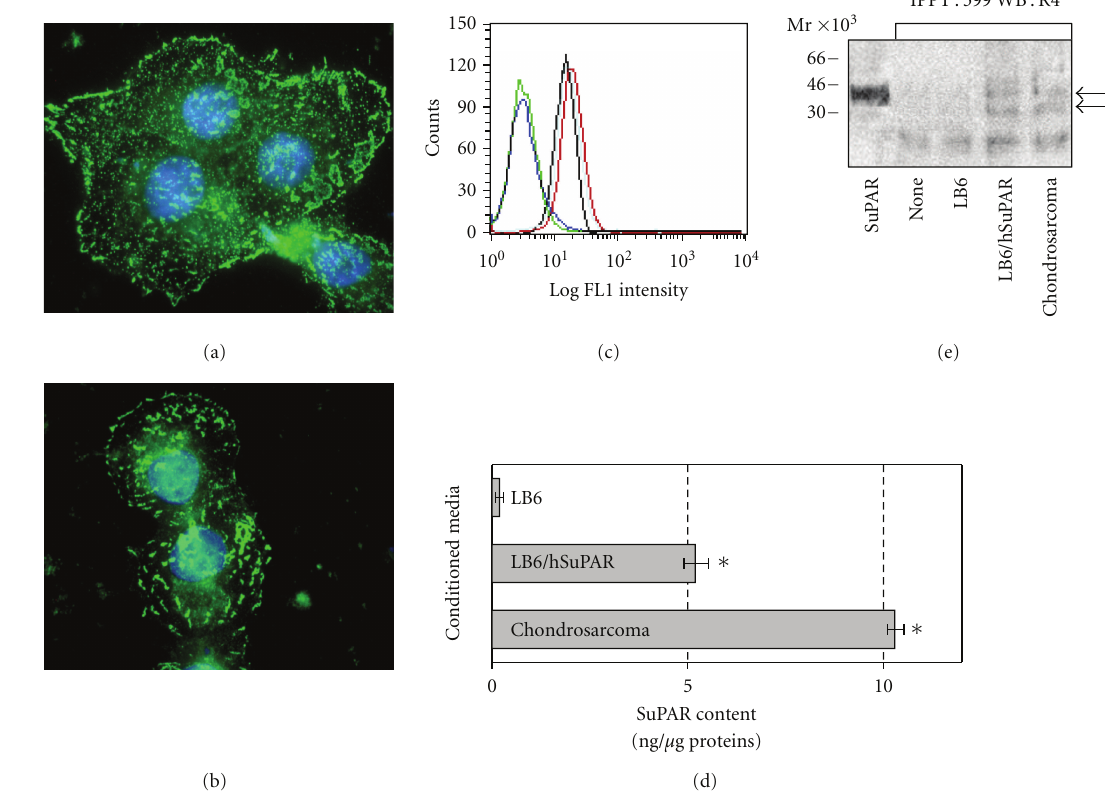
Figure 4: Chondrosarcoma cells express uPAR and release its soluble forms in the medium. Chondrosarcoma cells were fixed with 2.5% formaldeyde (a) or fixed with 2.5% formaldeyde and permeabilized with 0.2% Triton X-100 (b) for 10min at 4 ◦ C, incubated overnight at 4 ◦ C with 2 μ g/mL R4 anti-uPAR mAb and then exposed to Alexa 488-conjugated F(ab’)2 fragment of rabbit anti-mouse IgG (green). Nuclei were stained blue with DAPI. Original magnification: x1000. (c) Flow cytometry analysis of uPAR on chondrosarcoma and HT1080